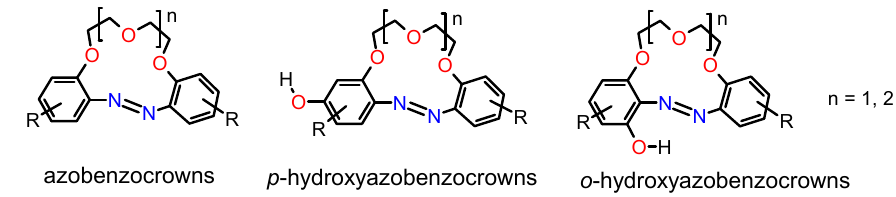
Figure 1. General chemical formulas of azobenzocrowns and hydroxyazobenzocrowns [14–26].